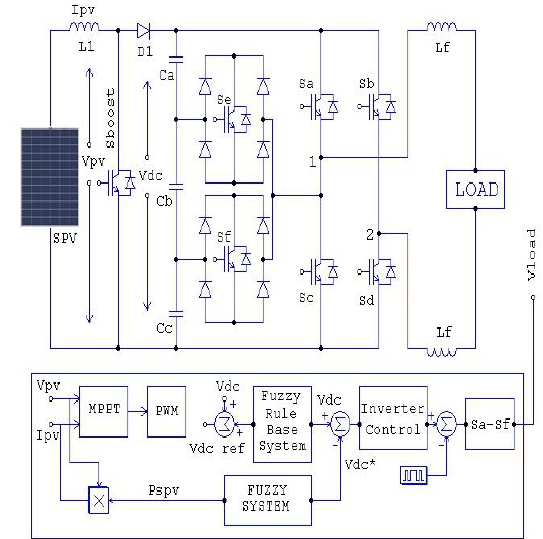
Figure 9 . 1 ∅ Seven Level Inverter by Closed-Loop System EAI Endorsed Transactions on Energy Web 12 2022 - 12 2022 | Volume 9 | Issue 5 |